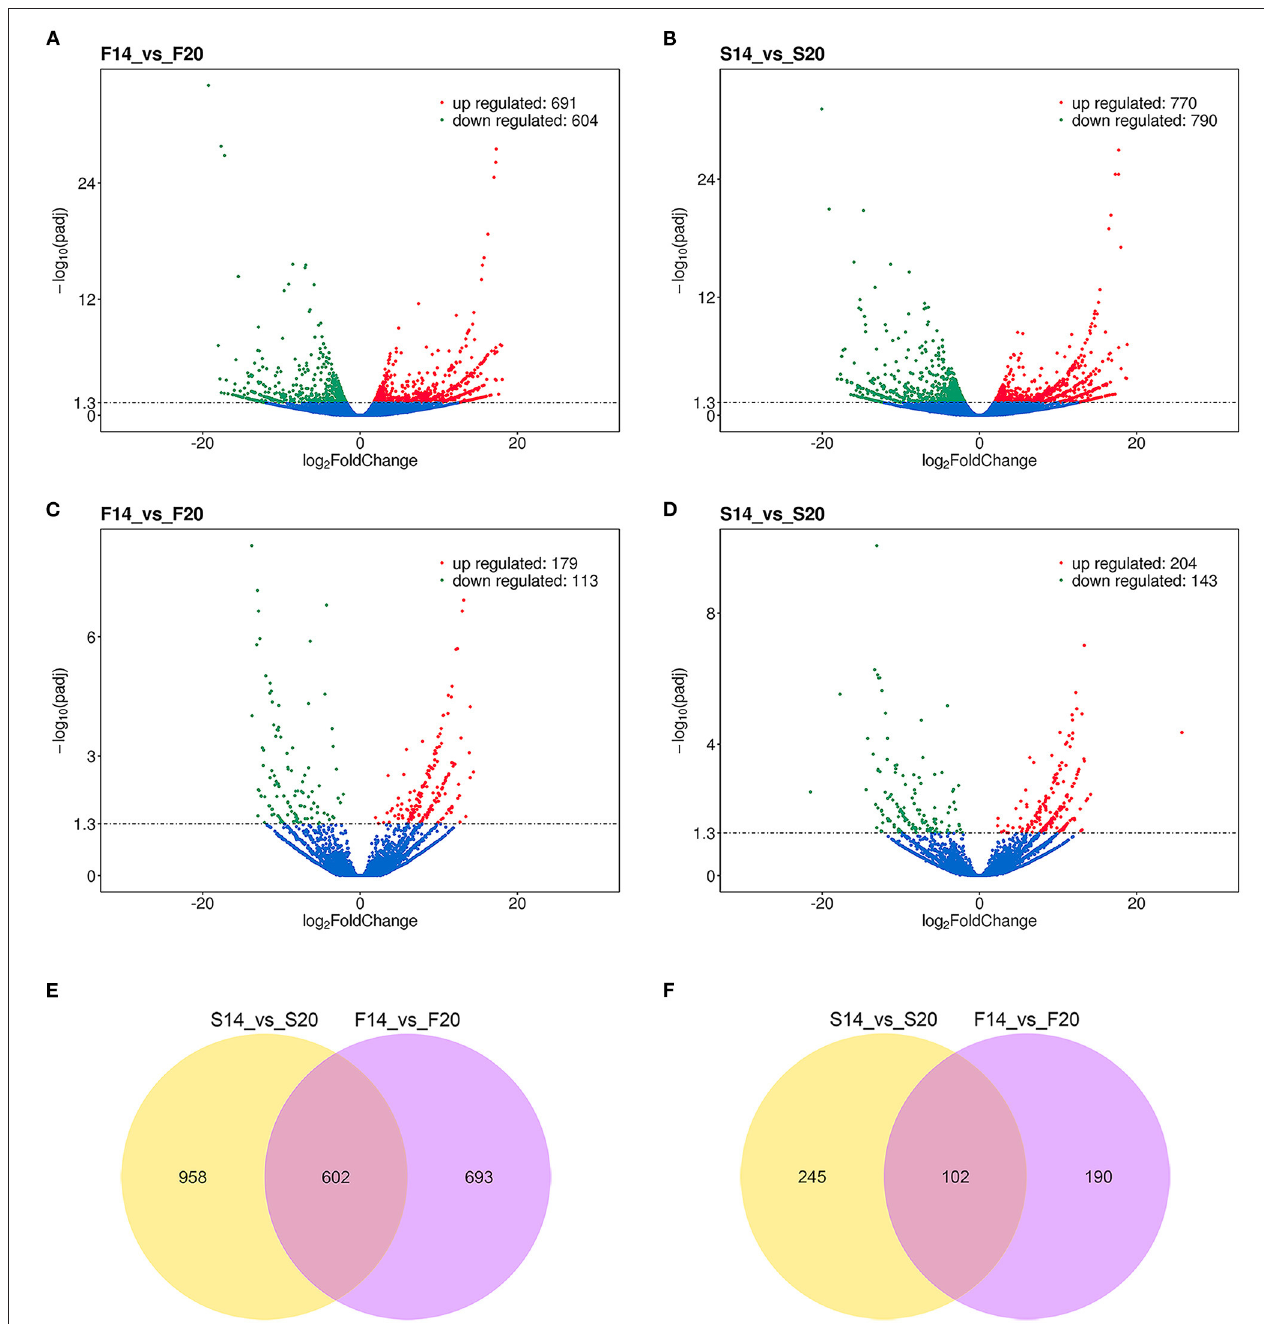
FIGURE 3 | Results of differential expression analysis. (A) Differentially expressed mRNAs of F14vsF20; (B) Differentially expressed mRNAs of S14vsS20; (C) Differentially expressed lncRNAs of F14vsF20; (D) Differentially expressed lncRNAs of S14vsS20; (E) The same differentially expressed mRNAs in comparison groups S14vsS20 and F14vsF20; (F) The same differentially expressed lncRNAs in comparison groups S14vsS20 and